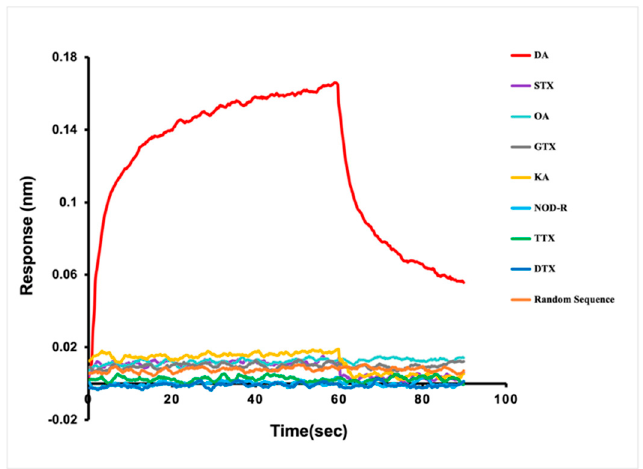
Figure 4. The affinity and specificity identification of C1-d for DA. The red, yellow, purple, cyan, gray, light blue, green, dark blue, and orange lines represent the binding curves of C1-d with DA, KA, saxitoxin (STX), okadaic acid (OA), gonyautoxin (GTX), nodularin-R (NOD-R), tetrodotoxin (TTX), dinophysistoxin (DTX), and random sequence, respectively. All the concentrations of toxins were 6.25 μ M.